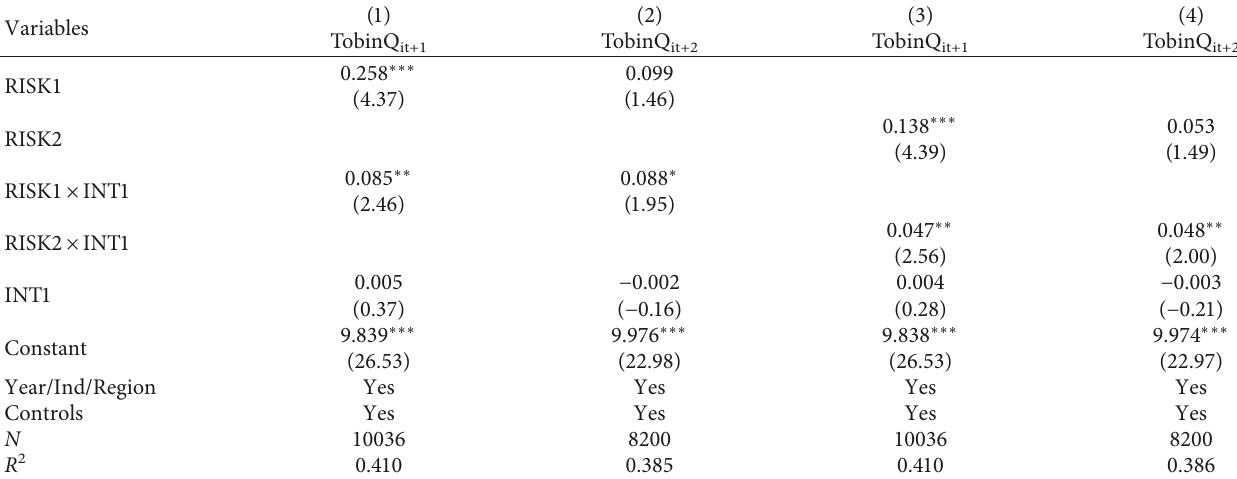
Table 8: Testing of consequences presented by corporate risk-taking under an Internet-based business model.